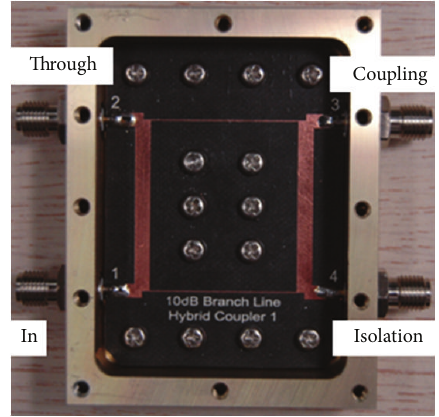
Figure 9: Fabricated 10dB hybrid coupler inserted into a metal housing.